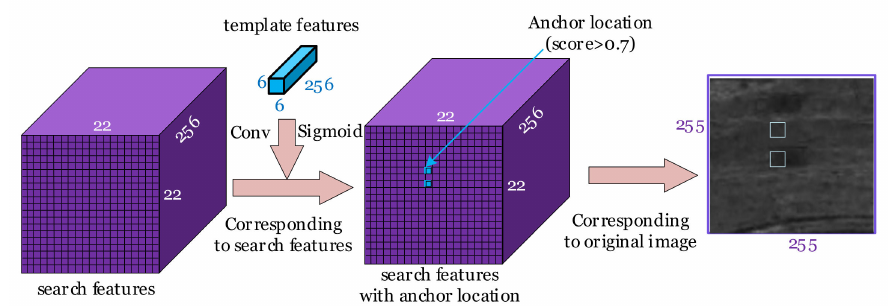
Figure 7. Predicting the anchor location.